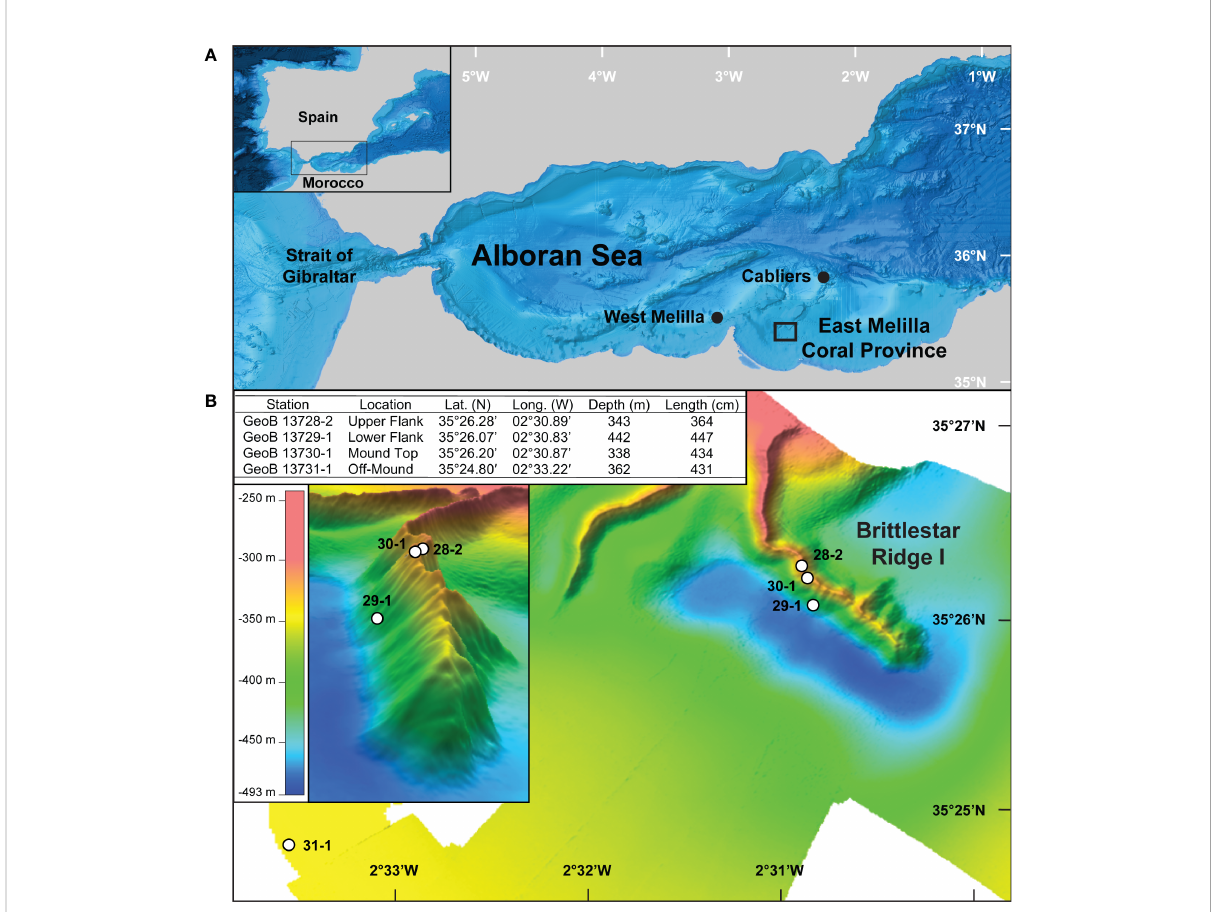
FIGURE 1 (A) Locality map of the Alboran Sea and East Melilla Coral Province as well as other known cold-water coral (CWC) mound provinces, West Melilla and Cabliers. (B) Bathymetry map of the CWC mound Brittlestar Ridge I in the East Melilla Coral Province with locations of the on-mound CWC reef sediment cores (GeoB13728-2, GeoB13729-1, and GeoB13730-1, labeled as 28-2, 29-1, and 30-1, respectively) and the off-mound sediment core (GeoB13731-1, labeled as 31-1; located in the far lower left corner) used for palaeoceanographic reconstructions (Fink et al., 2013; Portilho-Ramos et al., 2022). Inset in (B) provide core metadata and the location of the on-mound cores in pro fi